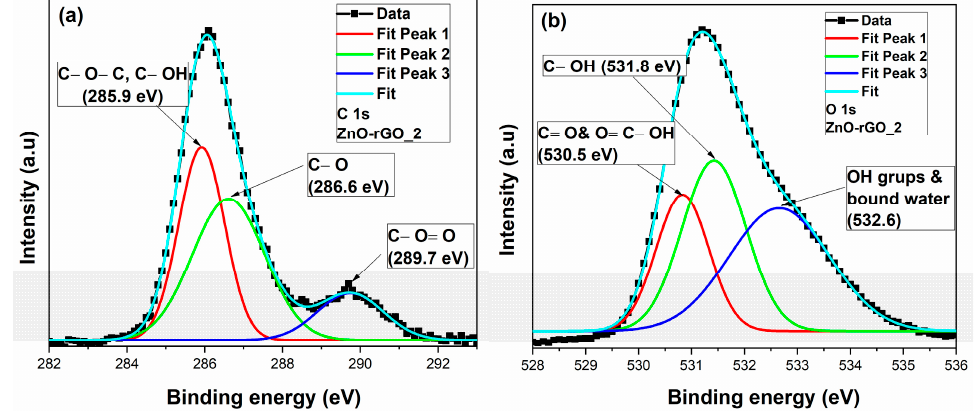
11 of 22 Figure 8. XPS ( a ) survey spectra of ZnO and ZnO-rGO_3 and ( b ) Zn 2p spectrum for ZnO, ZnO-rGO_2 and ZnO-rGO_3. Figures 9 and 10 show the XPS spectrum of the C 1 s and O 1 s bands of ZnO-rGO_2 and ZnO- rGO_3 thin films, in which are presented the O and C, functional groups. On the one hand, analysis of the high-resolution C 1 s spectra using a peak of deconvolution (Figure 9a and Figure 10a), revealed three functional groups around 285.8 eV (C–O–C, C–OH), 286.3 eV (C–O) and 289.1 eV (C–O=O) [38]. On the other hand, the O 1 s spectrum initially appeared at a binding energy of 531.3 eV (Figure 9b and Figure 10b). After its deconvolution, it contained three contributions around 530.8 eV (C=O, O=C–OH), 531.42 eV (C–OH) and 532.66 eV (OH, H 2 O). The 530.8 eV peak is attributed to the lattice O while the other two components are related to C=O and C–O (sp 3 ) [39]. The assignments of the mentioned functional groups are in agreement with the literature [38,39]. The XPS results, shown in Figure 9 and Figure 10, clearly indicate variations in the oxygen and carbon content for the ZnO_rGO_2 and ZnO_rGO_3 samples. The ZnO_rGO_2 nanocomposite has more oxygen and zinc content than the ZnO_rGO_3 sample, whereas the ZnO_rGO_3 sample has a